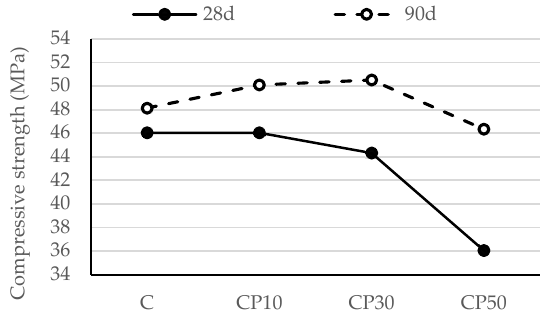
Figure 6. Compressive strength of mortars blended with ceramic powder.